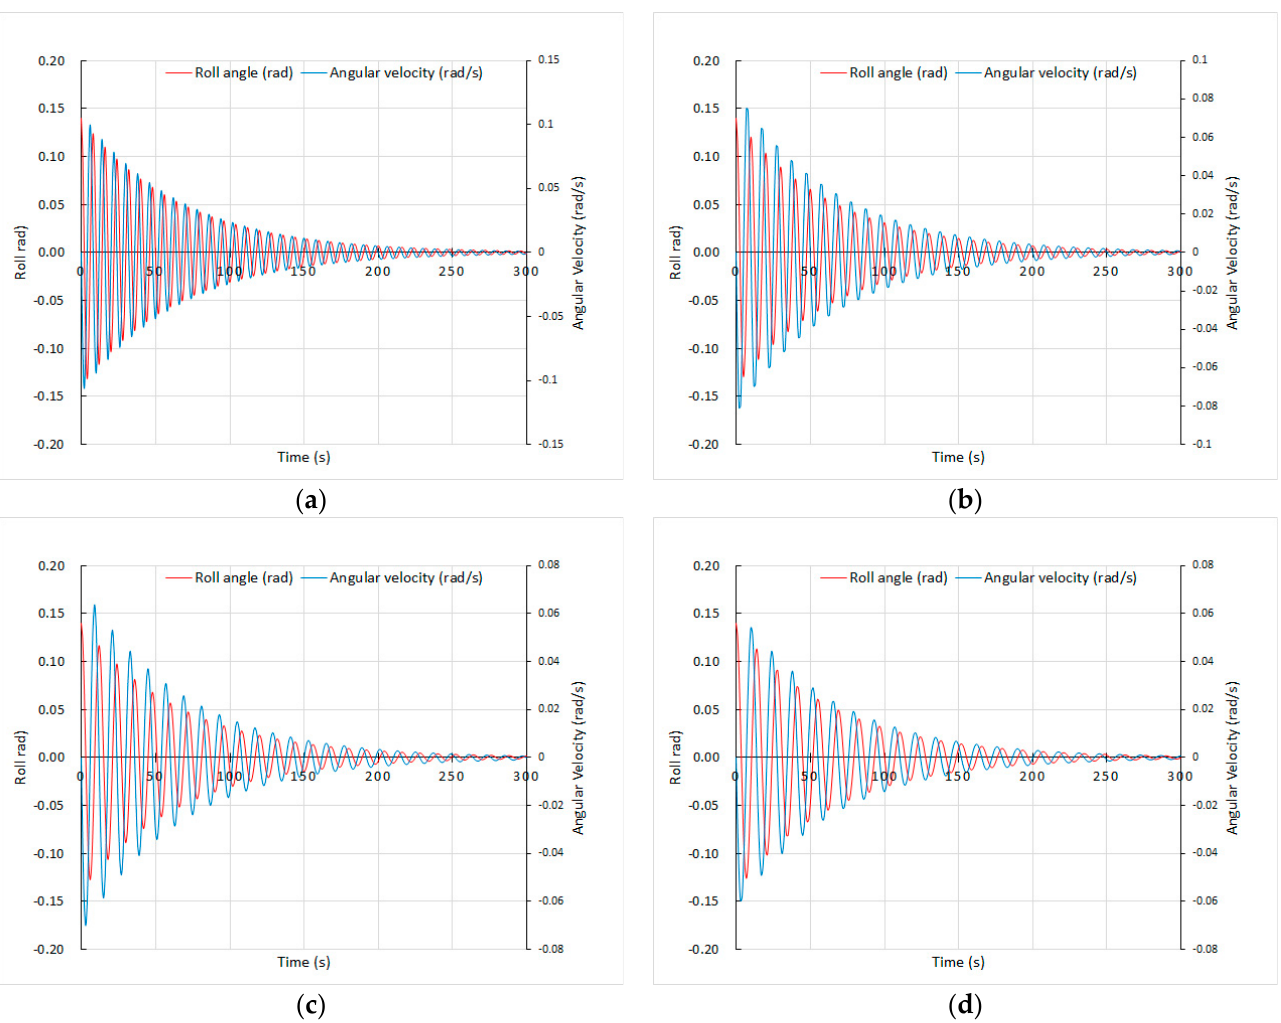
Figure 2. Rolling angle and the corresponding angular velocity for di ff erent loading conditions. ( a ) Td = 8 s, ( b ) Td = 10 s, ( c ) Td = 12 s, and ( d ) Td = 14 s.